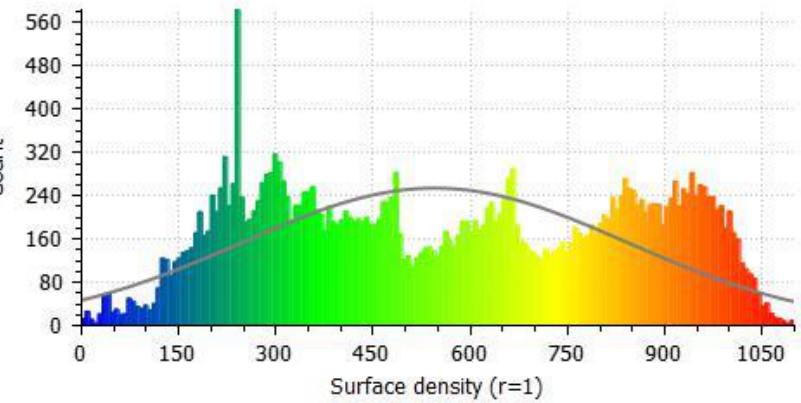
Figure 5. Histogram of surface densities at each point contained within the excavator point cloud is located in Figure 4. The x -axis is surface density, and the y -axis is the number of points on the excavator with that surface density. The colors depict the different densities with blue being least dense to red most dense.